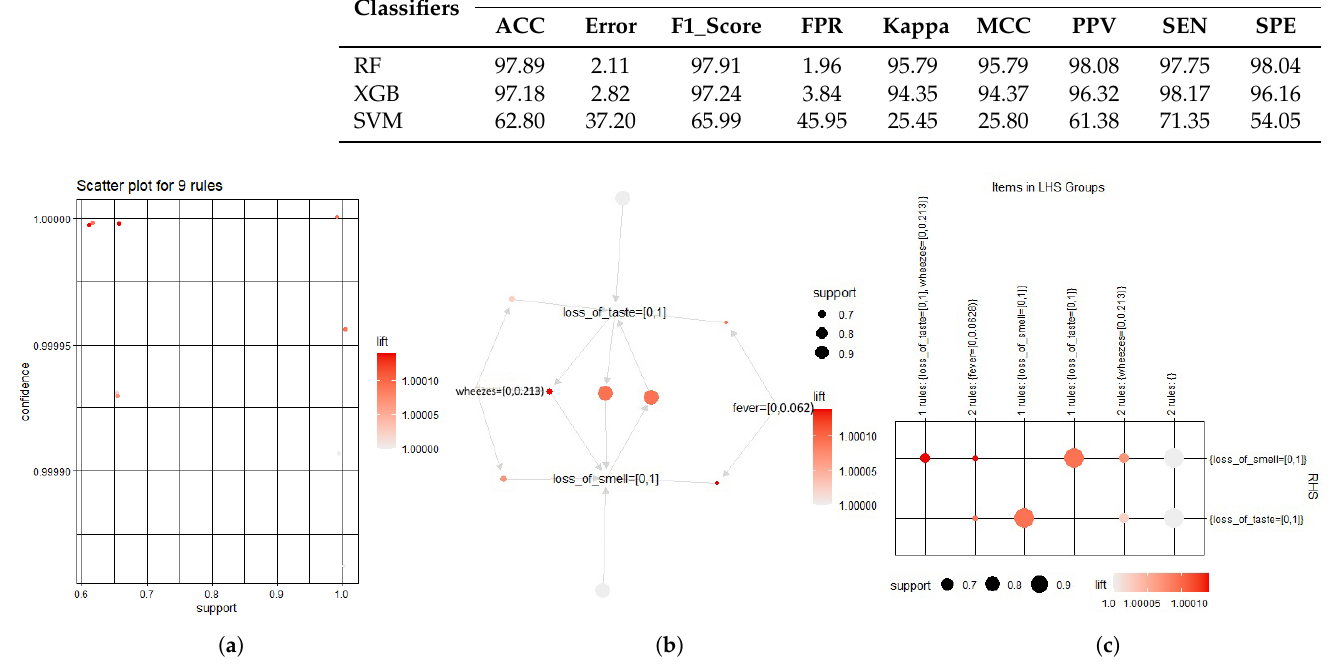
Figure 9. Association rules ( a ) scatter plot, ( b ) support and lift, and ( c ) items in the left hand side (LHS) and the right hand side (RHS)